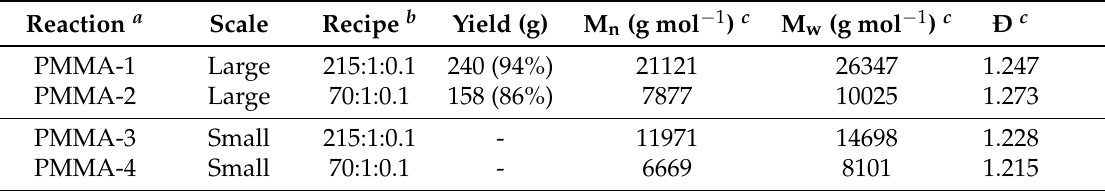
Table 5. Final product properties for all polymerization reactions.